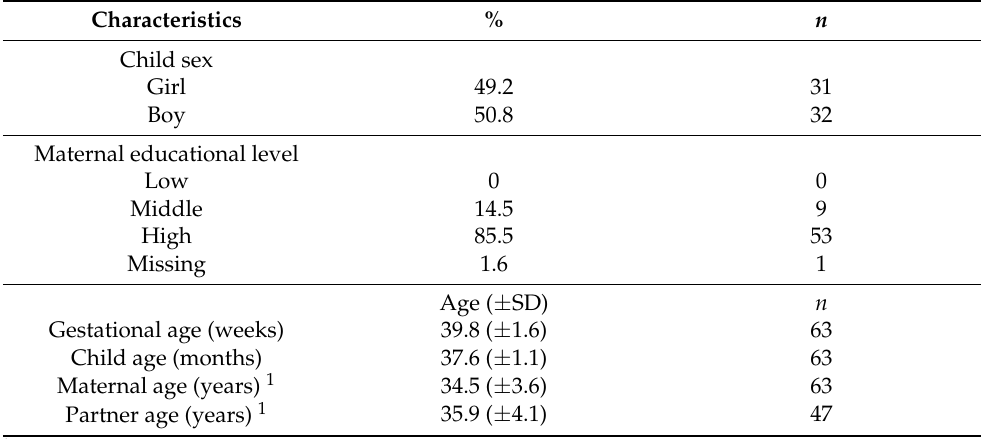
Table 1. Study population characteristics.